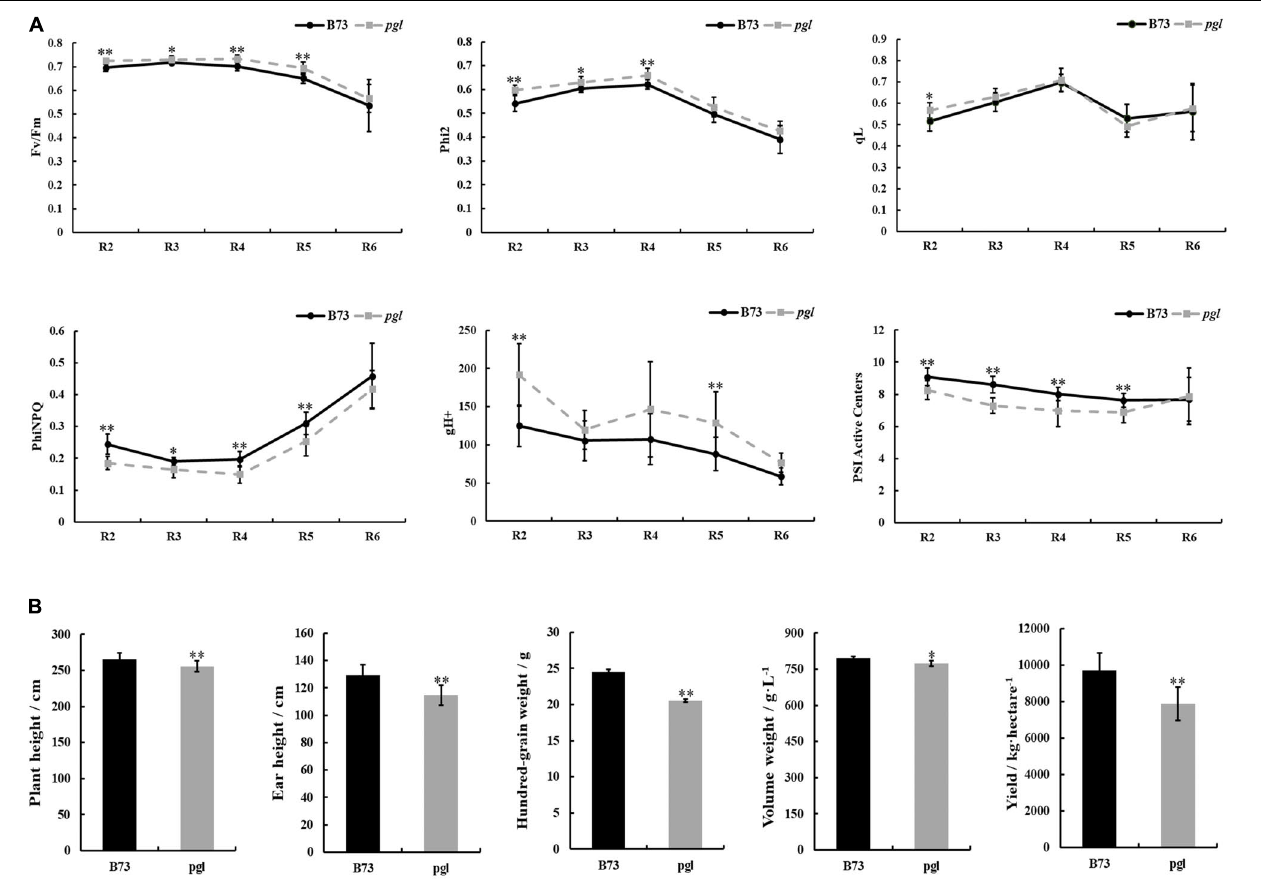
FIGURE 7 | Chlorophyll fluorescence kinetic parameters of photosystem and comparison of production between B73 and pgl mutant. (A) The chlorophyll fluorescence parameters of the middle of ear leaves were measured in B73 and pgl at the reproductive stage. R2, blister stage; R3, milk stage; R4, dough stage; R5, dent stage; R6, physiological maturity stage. Data were calculated as the means ± SD ( n = 8). (B) The agronomic traits were analyzed between B73 and pgl . Height data were calculated as the means ± SD ( n = 10) and yield data were calculated as means ± SD ( n = 3). Asterisks represent significant differences between B73 and pgl mutant detected by independent sample T -test ( ∗ P < 0.05, ∗∗ P <